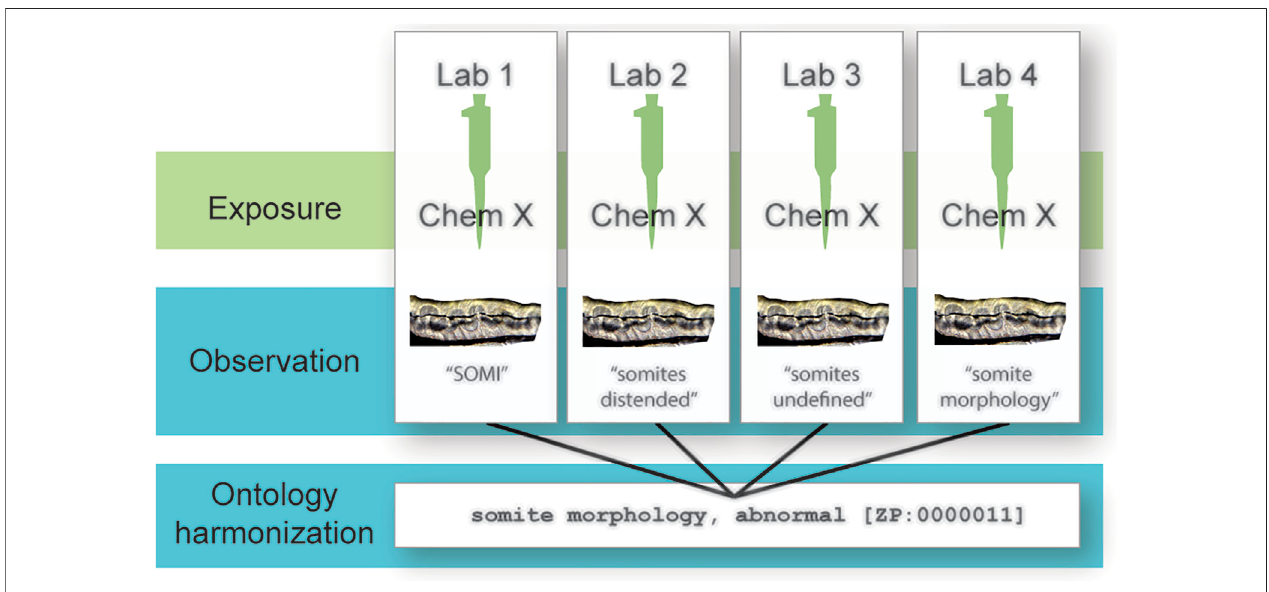
FIGURE 1 | Reducing data heterogeneity with ontologies. Different laboratories test the same chemical and observe the same endpoint but report their observations differently according to each laboratory ’ s internal standard. Mapping these terms to an ontology reduces this heterogeneity and aids in data integration across